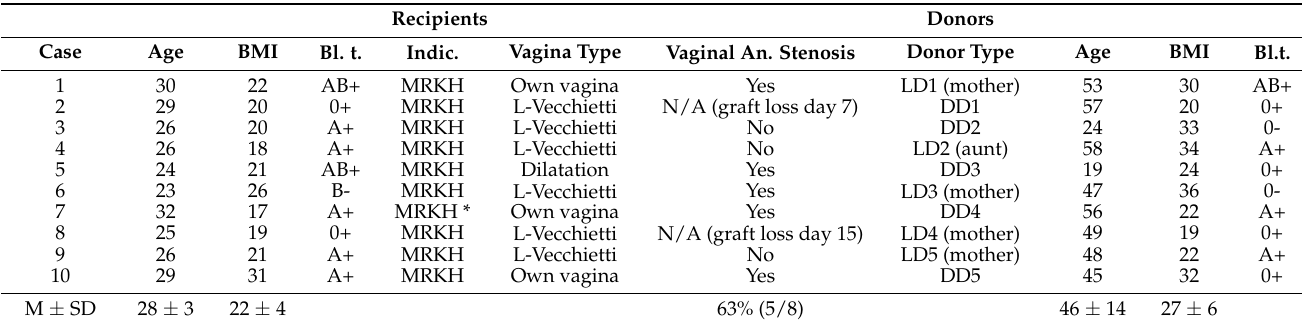
* right kidney agenesis. Abbreviations: age (years), anastomosis (an.), blood type (Bl.t.), body mass index (BMI, kg/m 2 ), deceased donor (DD), indication (Indic.), laparoscopic (L), live donor (LD), mean (M.), Mayer–Rokitansky–K˝uster-Hauser syndrome (MRKH), mean ± standard deviation (SD) and not applicable